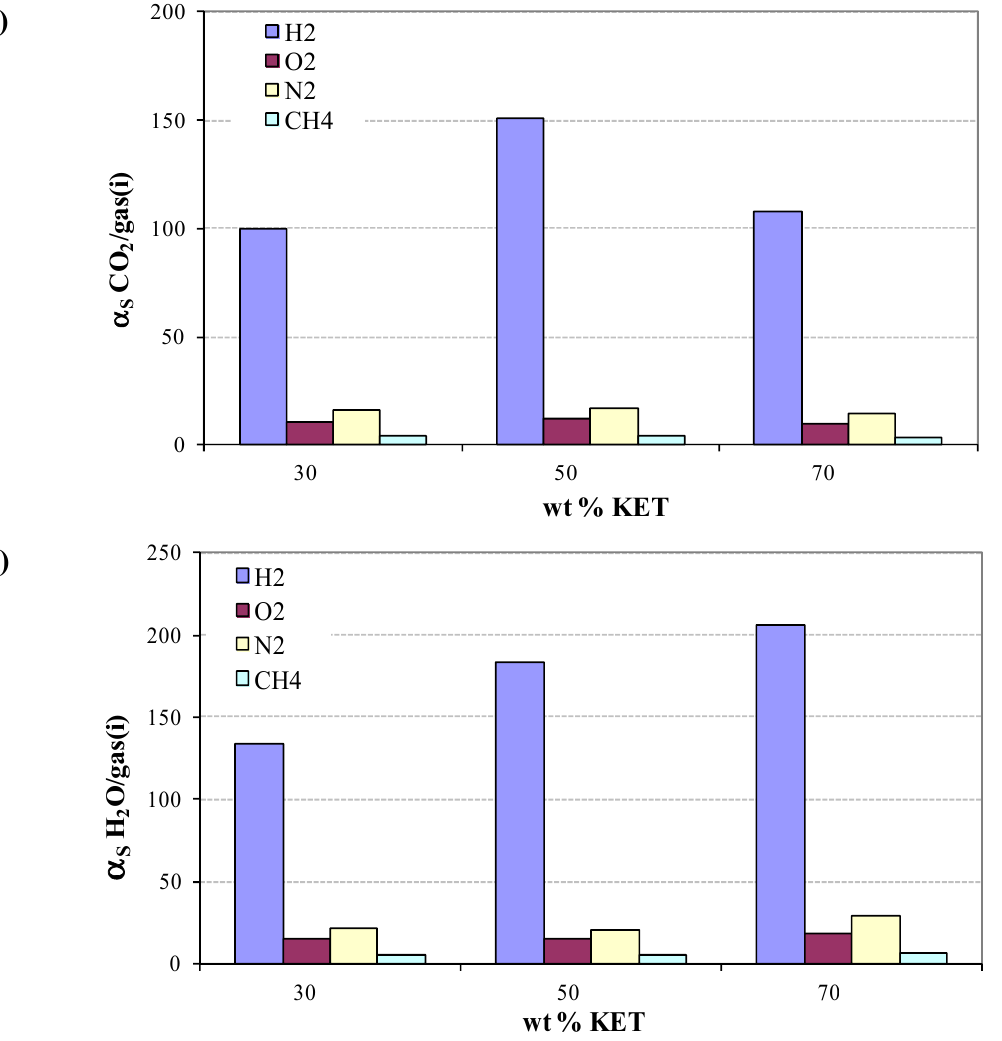
Figure 6. Solubility selectivity of ( a ) CO concentrations of